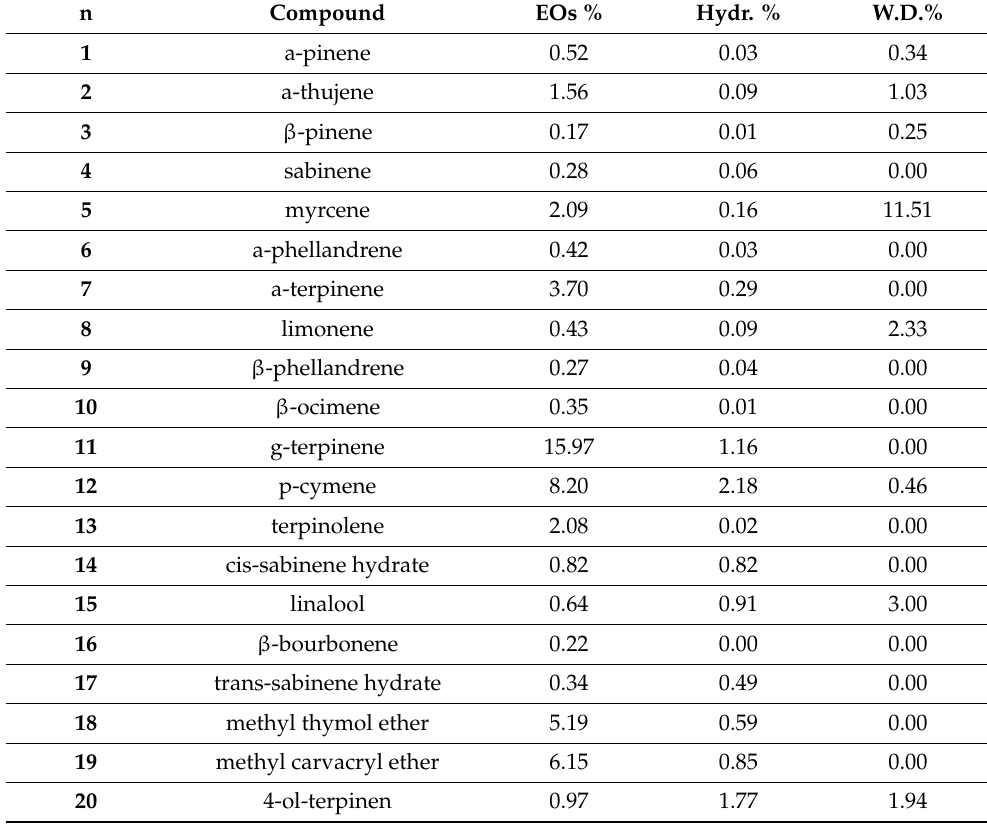
Table 1. Relative contents (%) of volatile terpenoids of Oregano vulgare L. essential oil. EOs %: essential oil; Hydr.%.: hydrolate; W.D.%: water distillation.